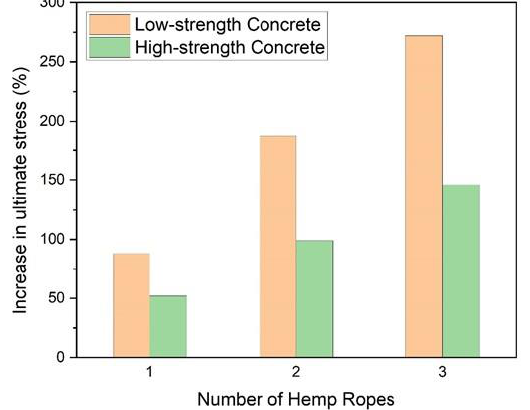
Figure 8. Stress–strain response of Type-2 concrete with and without hemp ropes confinement. Figure 8. Stress – strain response of Type-2 concrete with and without hemp ropes confinement.